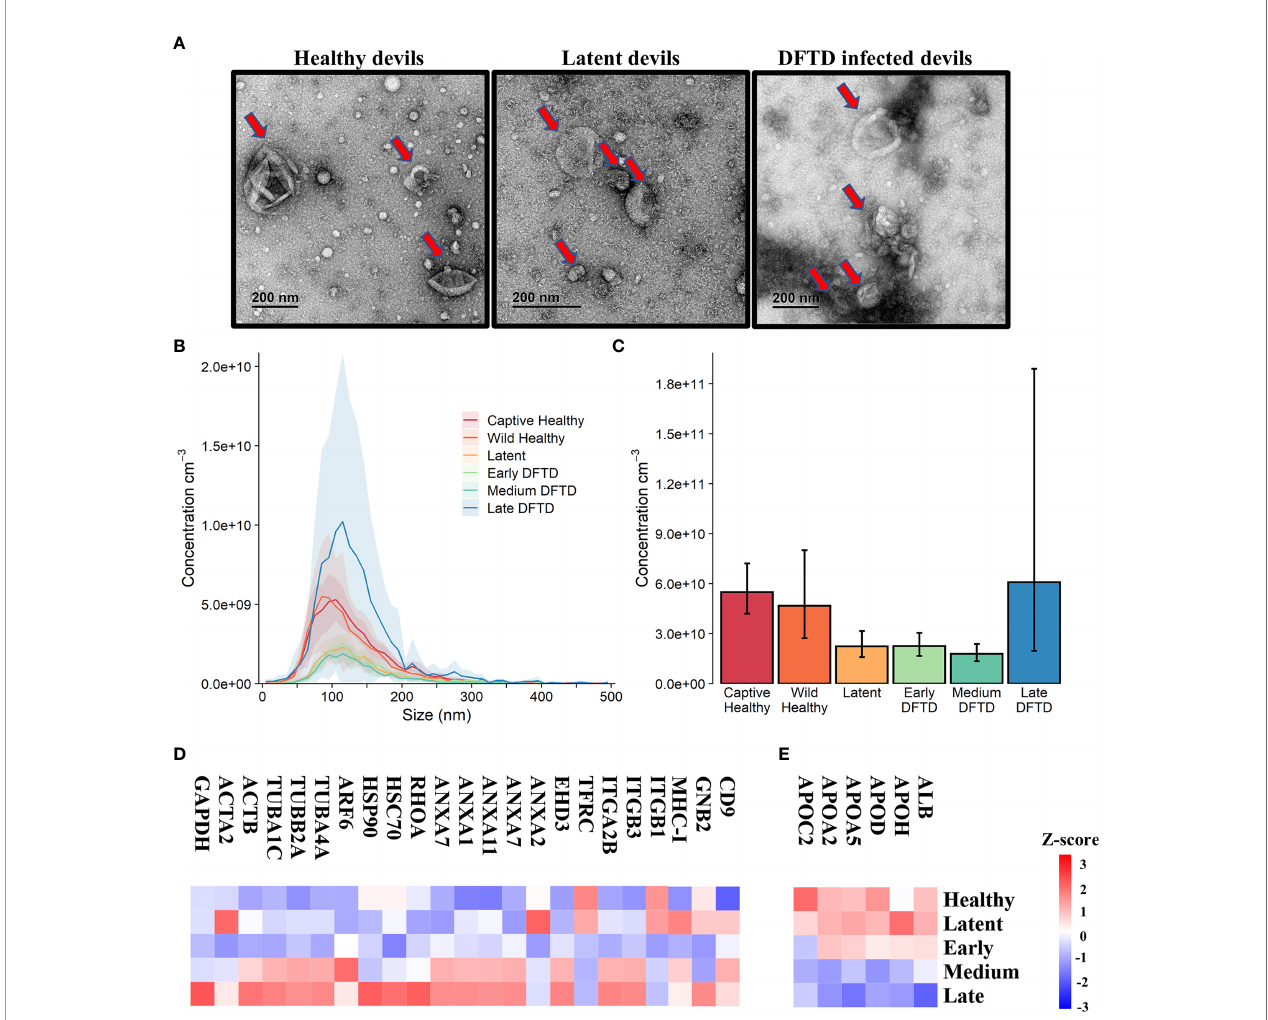
FIGURE 1 | Characterization of extracellular vesicles (EVs) derived from Tasmanian devil serum. (A) Transmission electron microscopy images for EVs isolated from the serum of healthy control wild devils from an isolated disease-free population (n=4), latent DFTD devils (n=4) and DFTD infected devils (n=4). Red arrows indicate EV structures. (B) Size distribution pro fi les determined by nanoparticle tracking analysis (NTA) of EVs isolated from the serum of captive (n=4) and wild (n=4) healthy control devils, latent DFTD devils (n=4), and DFTD infected devils in early (n=4), medium (n=4) and late stages (n=4). Shaded areas represent 95% con fi dence intervals. (C) EV concentrations of the same NTA groups. Error bars represent 95% con fi dence intervals. (D) Heat map of intensity values of commonly recovered EV proteins, and (E) serum contaminants (albumin and fi ve lipoproteins) found in EV samples derived from healthy controls (captive and wild) devils (n=27), latent DFTD devils (n=15), and devils in early (n=17), medium (n=15), and late (n=13) stages of